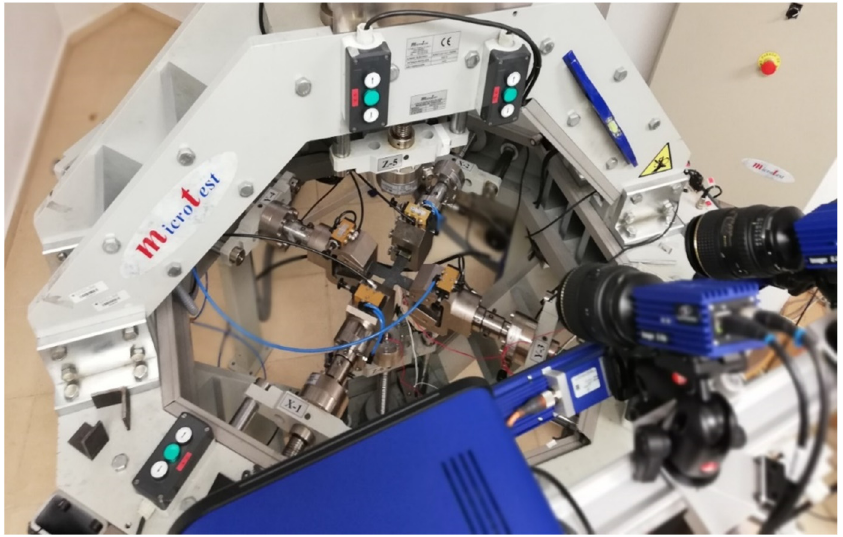
Figure 1. Triaxial testing facility of the UCLM.